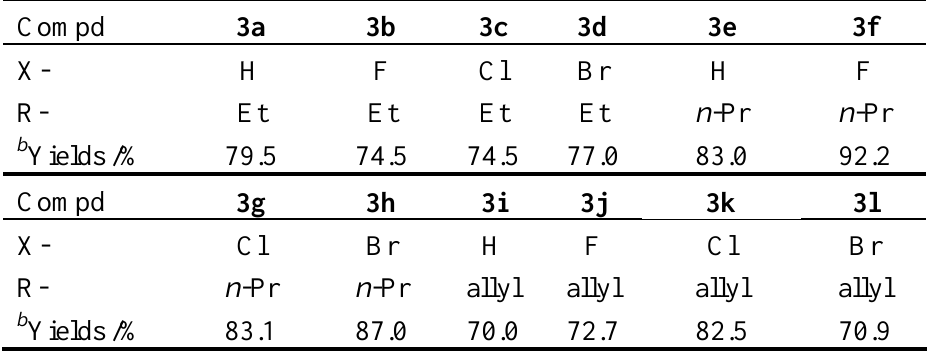
Table 3 . Yields of the title compounds 3 .